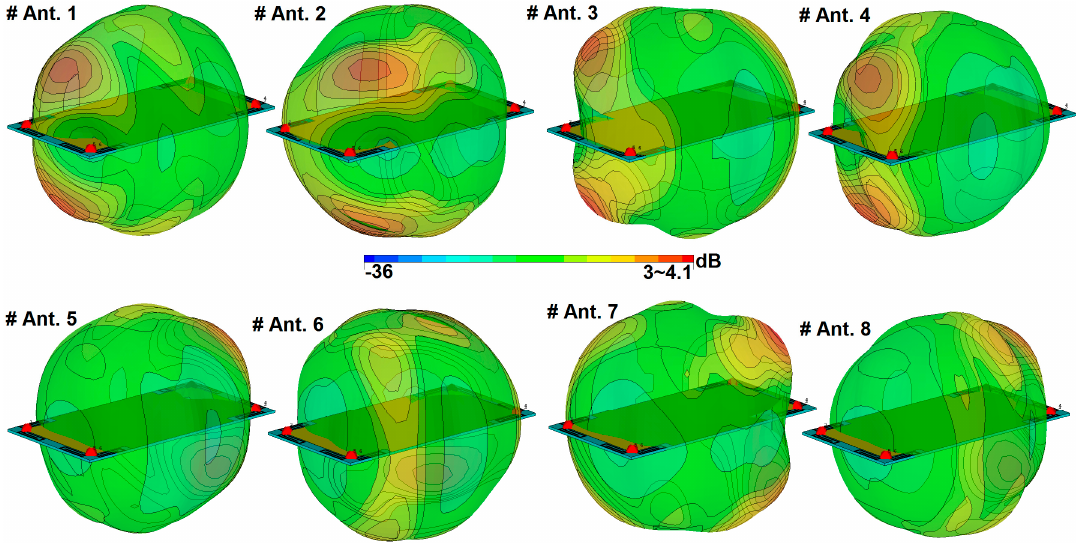
Figure 8. Radiation patterns of the PIFAs at the middle frequency (3.6 GHz). Sensors 2020 , 19 FOR PEER REVIEW